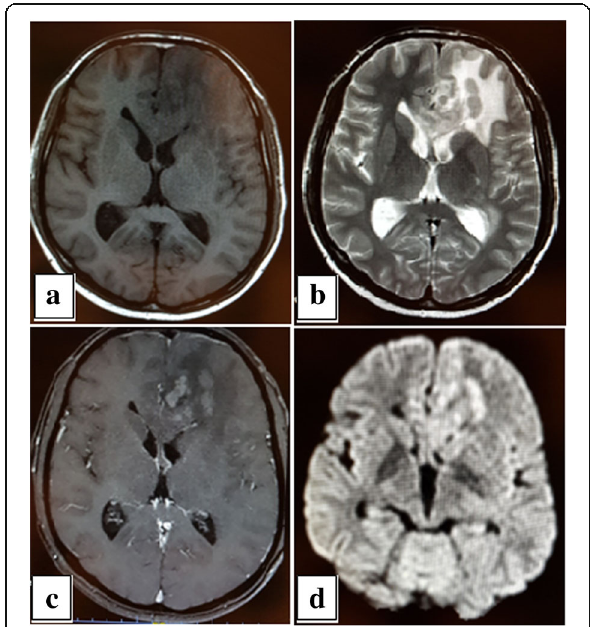
Fig. 1 CEMRI brain shows an ill-defined mass lesion in the left frontal and basifrontal region with corpus callosum extension. Lesion is iso to hypointense on T1W image ( a ) and iso to hyperintense on T2W image ( b ) and shows heterogenous contrast enhancement ( c ) with patchy areas of diffusion restriction ( d